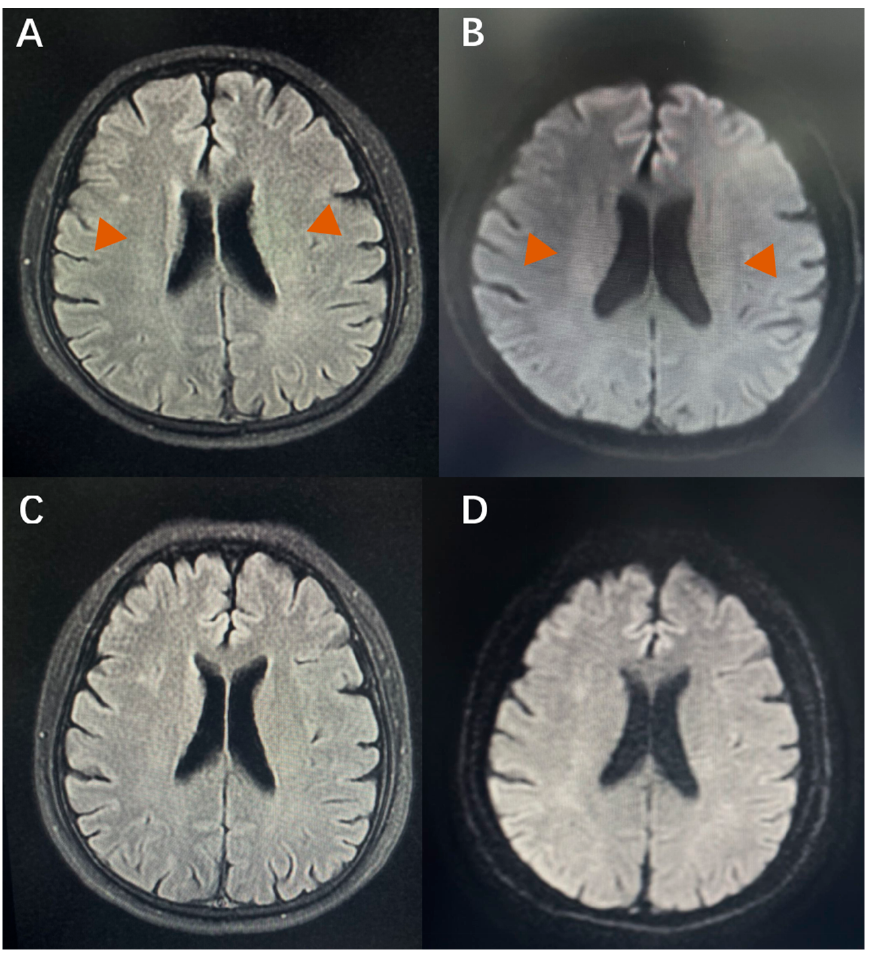
Figure 4. Cloudy-like WMLs (Red arrow) improved after stenting. Compared with the MR imaging before stenting ( A , B ), follow-up images showed attenuation in WMLs ( C , D ).